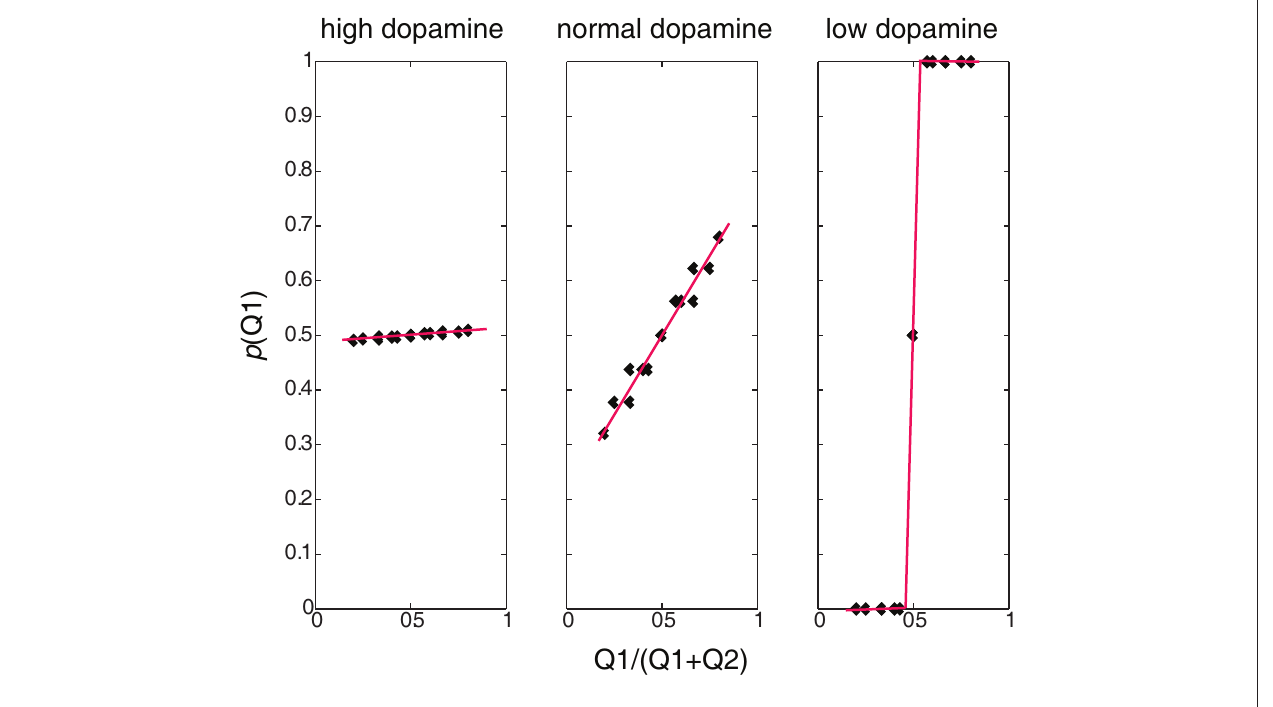
FigurE 2 | Behavioral policies at different β /dopamine levels. Probability of choosing Q1 as a function of the ratio between Q1 and (Q1 + Q2): high dopamine (low β ) – random policy, not dependent on the Q-value, normal (moderate dopamine and β ) – policy dependent on the